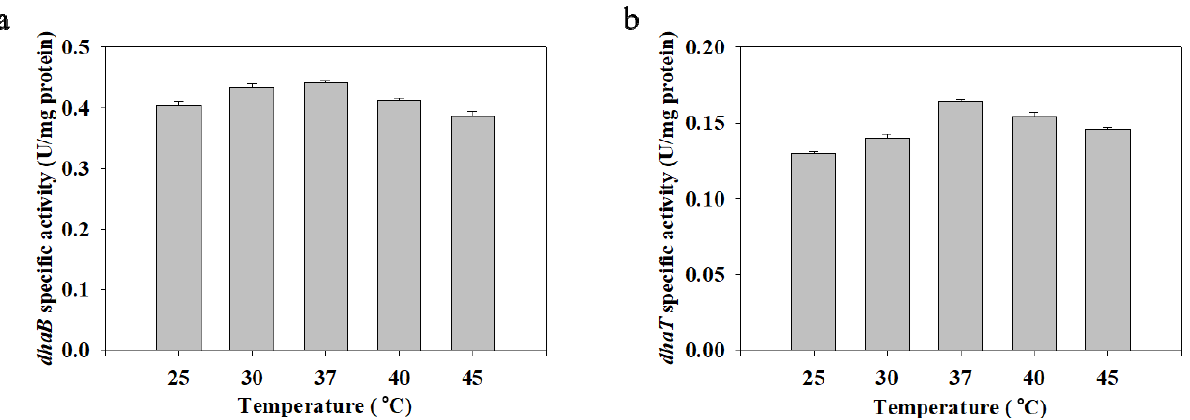
Figure 4. The Effect of temperature on the relative enzyme activity of vitamin B 12 -dependent glycerol dehydratase, dhaB ( a ) and 1,3-propanediol oxidoreductase, dhaT ( b ). All results are averages from three independent experiments.